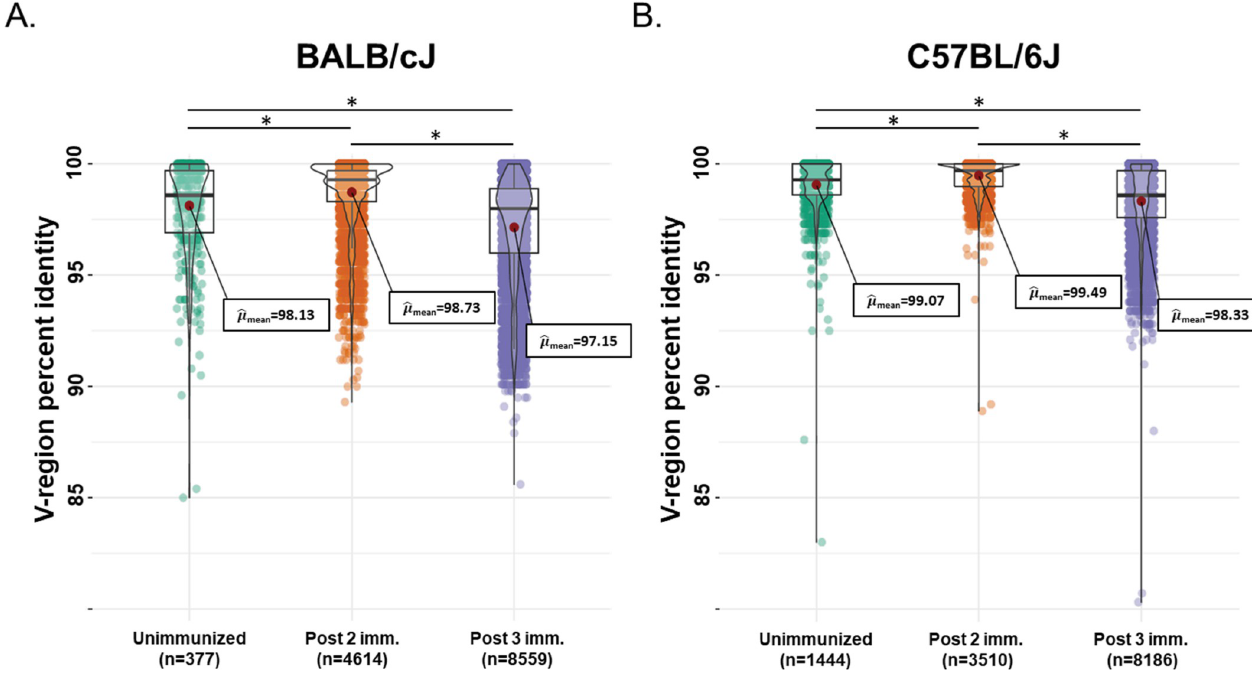
Fig 5. Py CSP-immunized BALB/cJ mice generate more highly diverse gamma-chain rearrangements than do C57BL/6J mice. V-regions of IgG heavy chains were amplified from isolated memory B cells of BALB/cJ (A) and C57BL/6J (B) mice and sequenced. Sequence libraries obtained from unimmunized mice (green) are shown in comparison to those derived from P yCSP-specific mouse memory B-cells at Week 3 (orange, post 2 nd immunization) and 7 (purple, post 3 rd immunization). The data shown are a representative set from three independent experiments. Each data point represents a deduplicated sequence (i.e., a group clustered at 100% sequence identity) and supported by at least 10 raw reads. The visualizations were analyzed and generated using the ggstatsplot (version 0.7.2) R package.